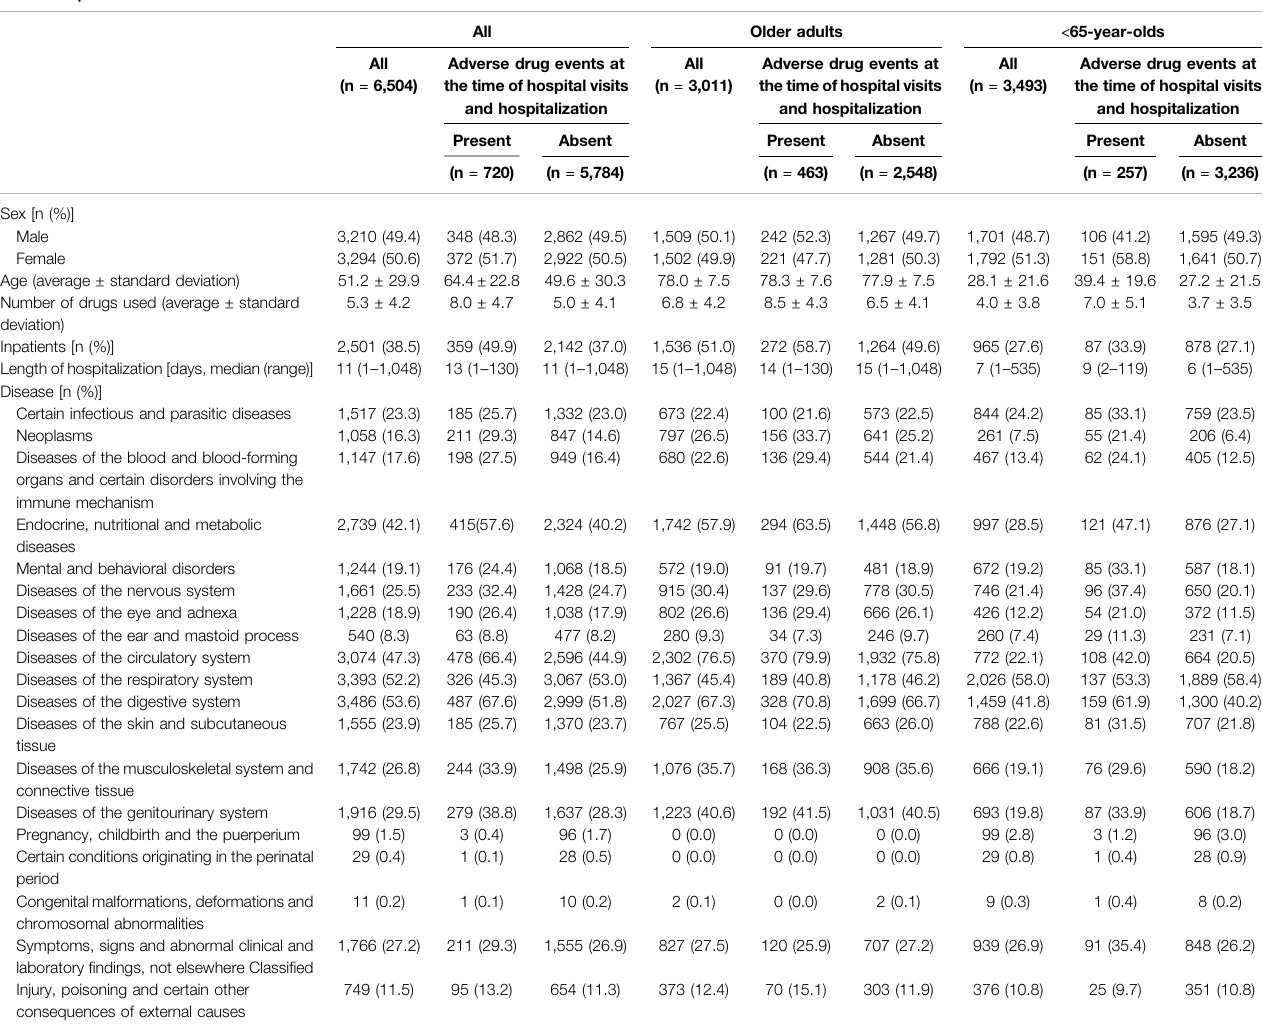
TABLE 2 | Patient characteristics.